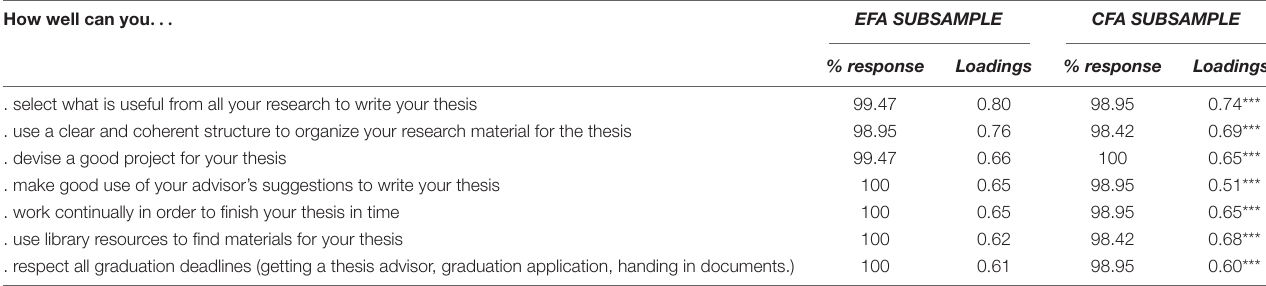
TABLE 2 | Item percentage of response frequency and factors loadings from the Exploratory Factor Analysis in a random subsample and Confirmatory Factor Analysis in the other subsample for the seven items related to the preparation of the thesis. How well can you